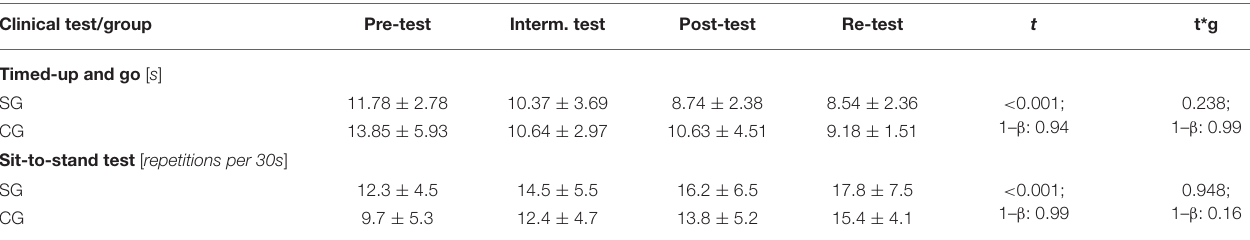
The p-values of the statistical analysis (ANOVA) are given in the right table section. The factors time (t) and time * group (t * g) were analyzed. Values are mean ± SD.